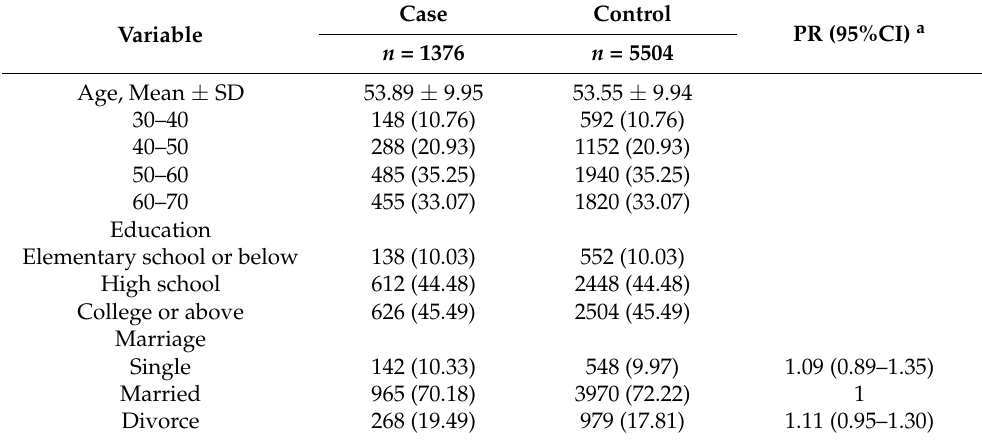
Table 1. Descriptive information of baseline characteristics of study